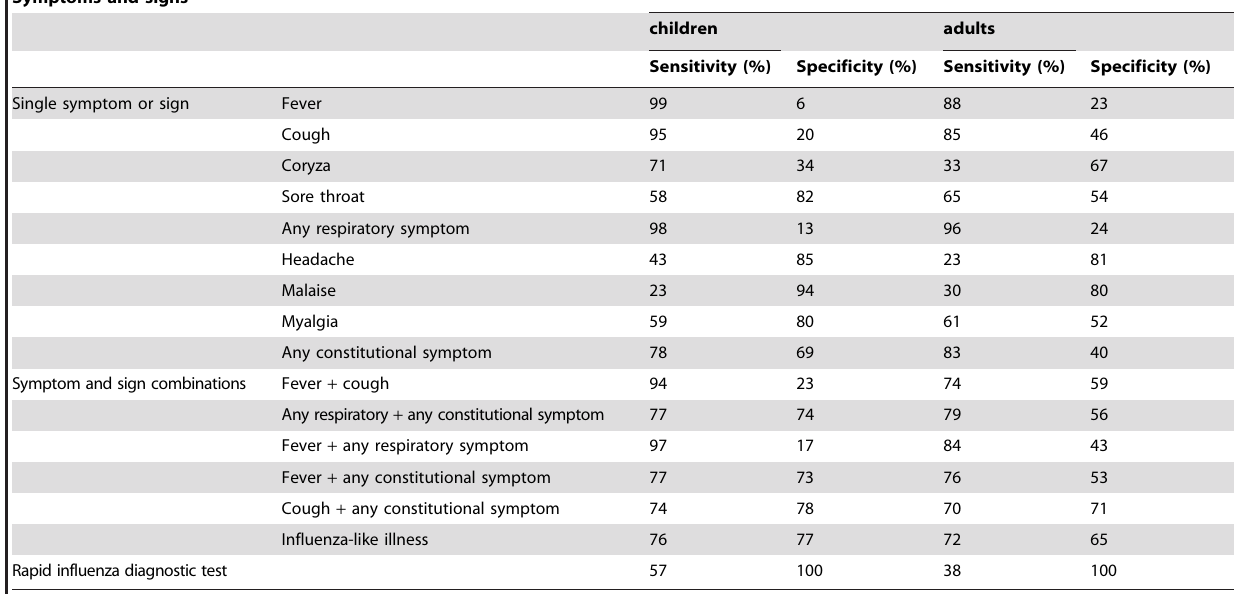
Table 3. Sensitivity and specificity of symptom and sign combinations for the identification of 2009 influenza A virus (H1N1) infection.